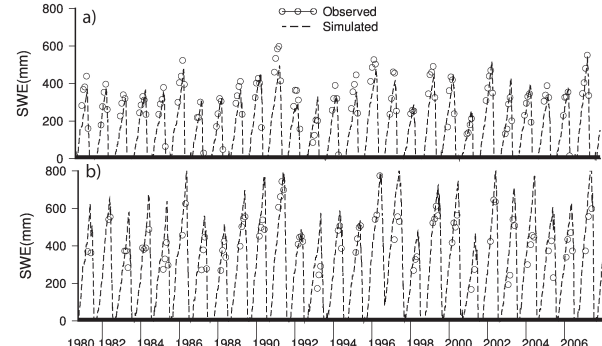
Fig. 9. Measured and model-predicted SWE for two locations in the upper Bow River basin; (a) Bow Summit (2080ma.s.l.) and (b) Katherine Lake